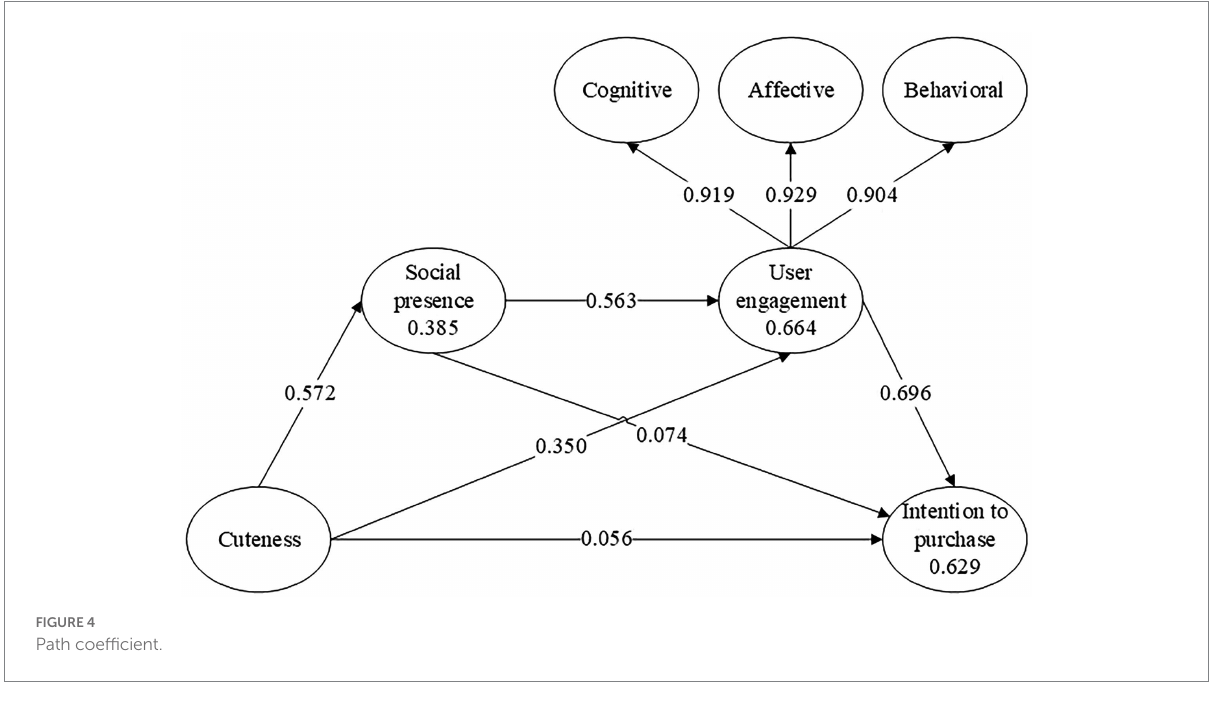
FIGURE 4 Path coefficient.